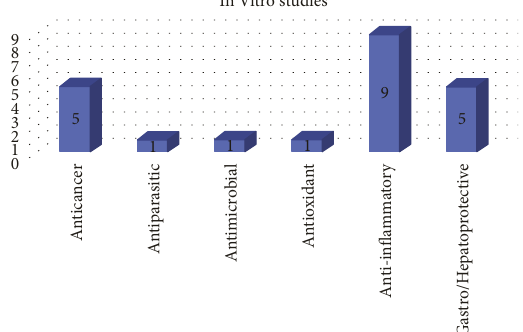
Figure 5: Quantification and classification of in vitro studies on solid dispersions published in the period from 2009 to 2020